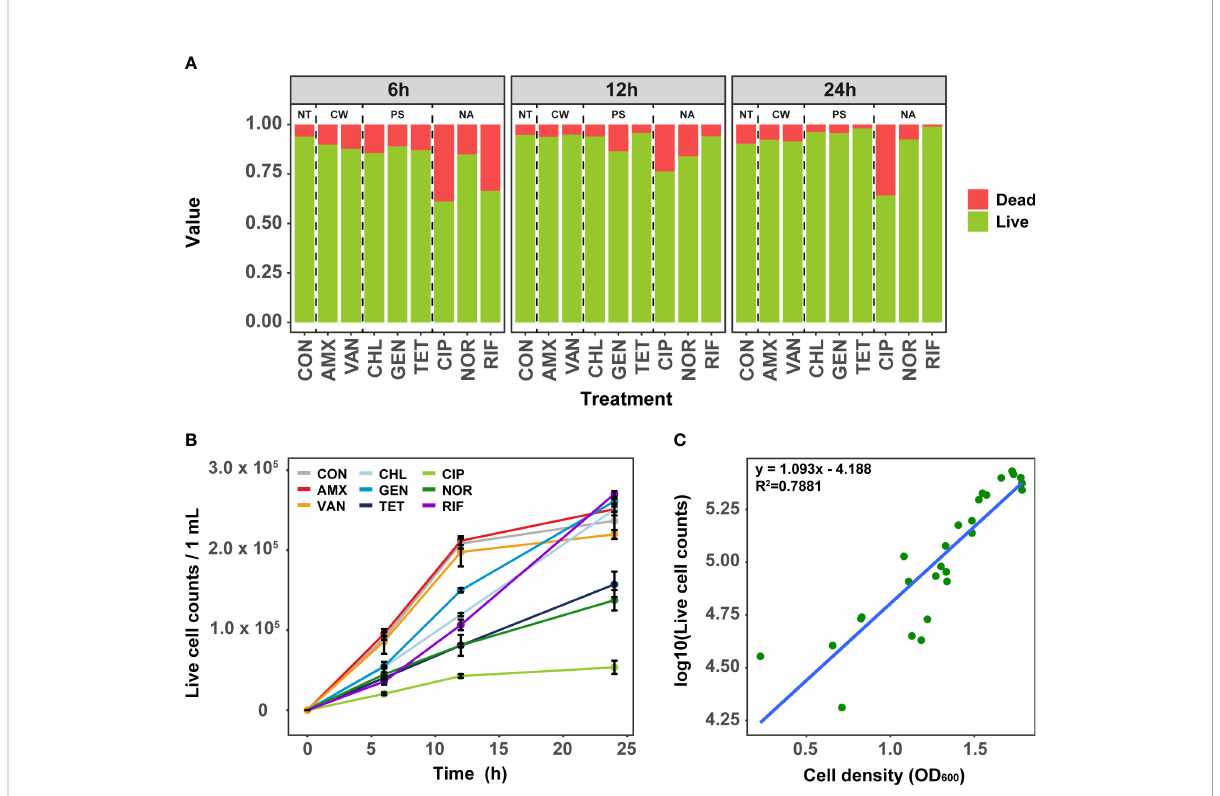
FIGURE 1 Analysis of cell viability in antibiotic-treated samples using Flow cytometry. (A) The change of ratio of live and dead cell over time. (B) Change of the live cell counts in samples treated with antibiotics over time. Error bars represent the mean ± SD. (C) The correlation between OD 600 and bacterial live cell counts for each samples. NT, antibiotic non-treatment; CON,